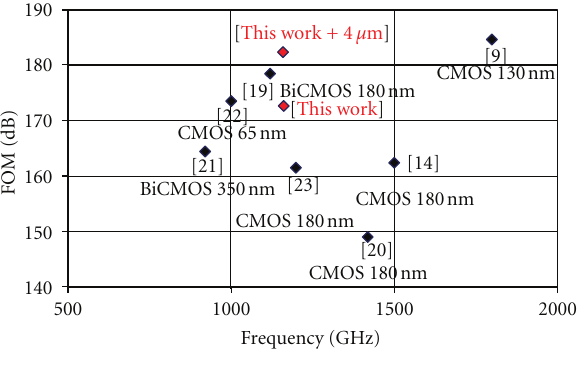
Figure 12: RTW VCO FOM comparison.